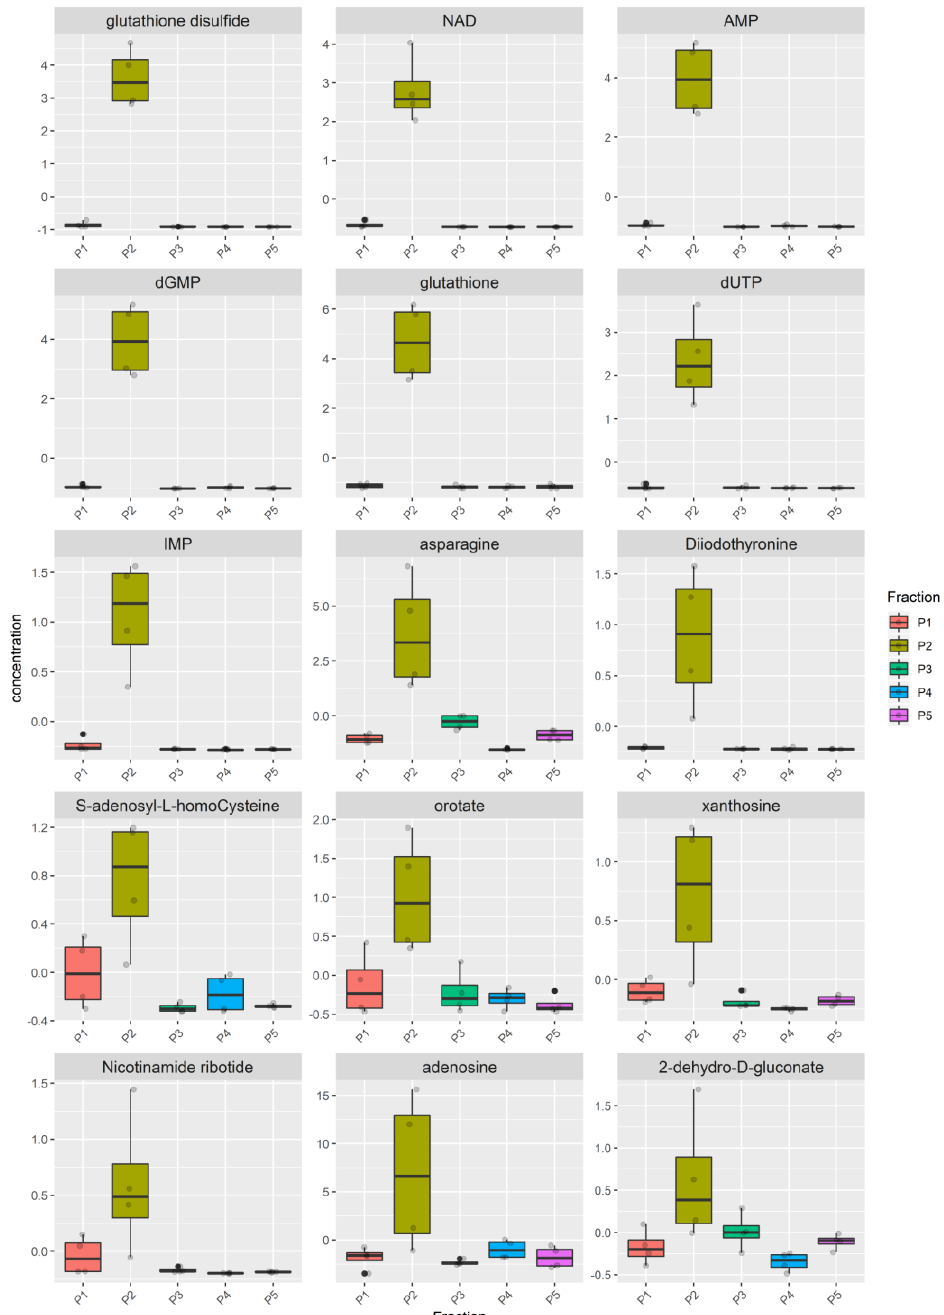
Figure 5. Metabolites enriched in the Donkey P2 fraction. For each fraction, four samples were analyzed. Raw data (quantitative relative ion count) were normalized using the Pareto Scaling normalization and analyzed using the ANOVA test. Only metabolites enriched in the Bovine P2 fraction are reported (FDR p < 0.05). The normalized concentration is reported for each metabolite in the P1, P2, P3, P4, P5 pools. The distribution of the samples is represented by a boxplot. The solid line represents the median, the box reports the interquartile range and the whiskers reports the minimum and maximum value of the distribution. Each sample is represented by a grey point, outliers are reported using a black